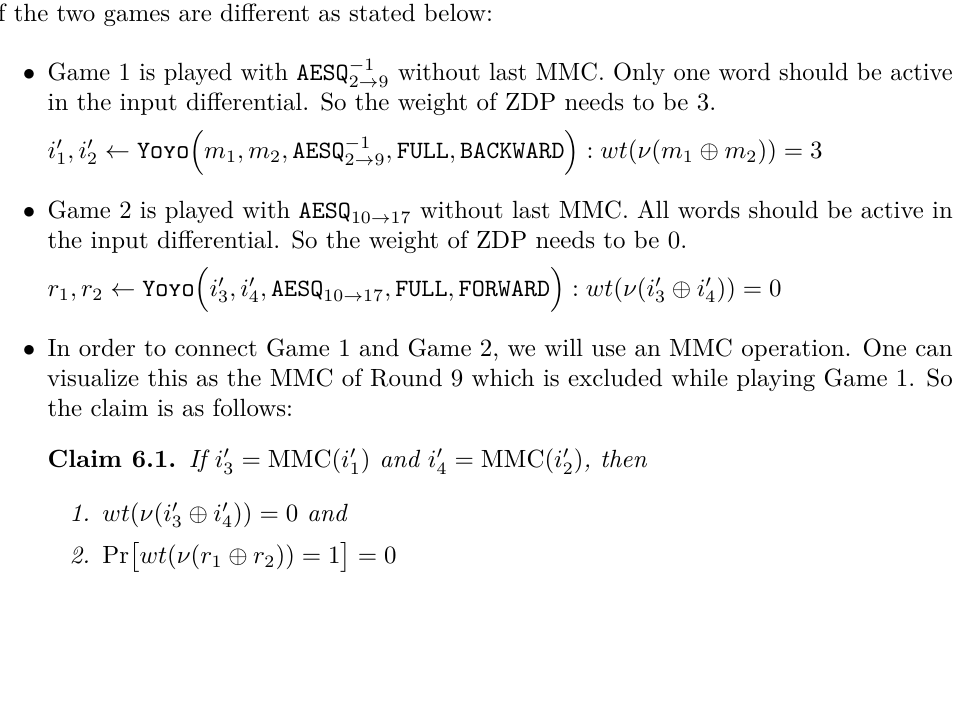
and AESQ 2 → 13 2 →